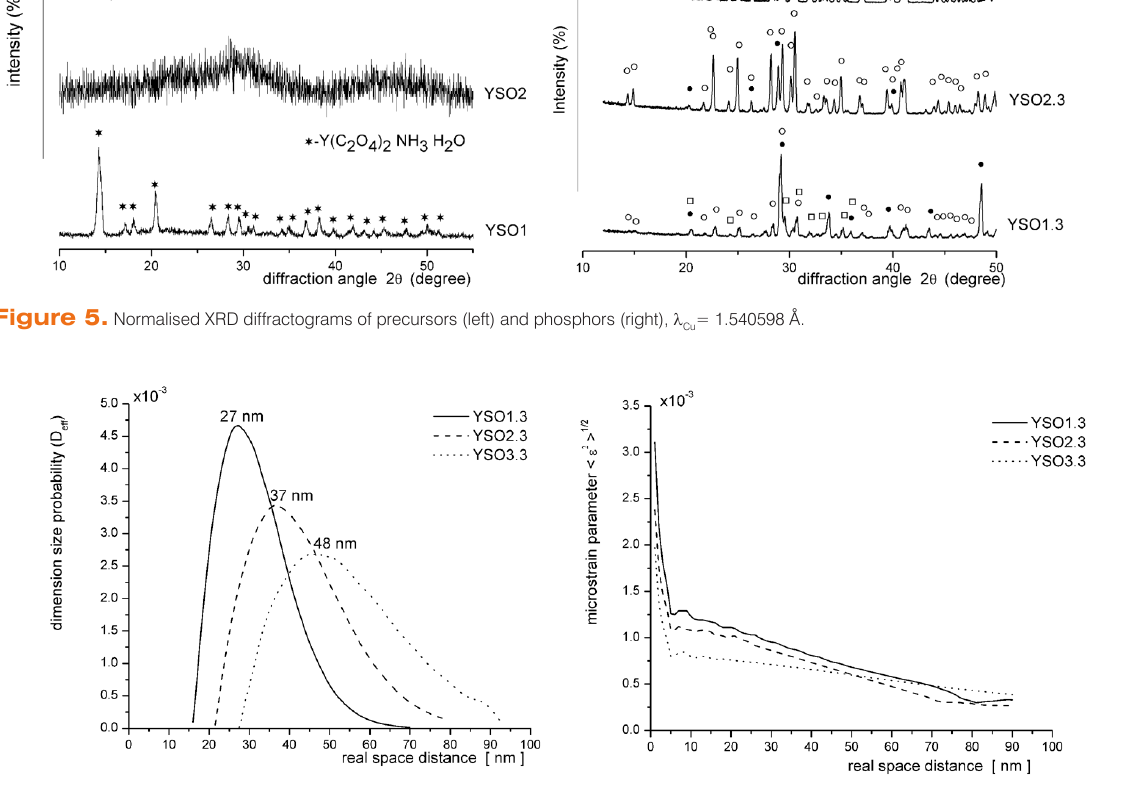
Figure 6. Crystallite size (left) and lattice stress (right) distribution of YSO samples. Table1. Phase composition, unit cell for phosphor samples and PL